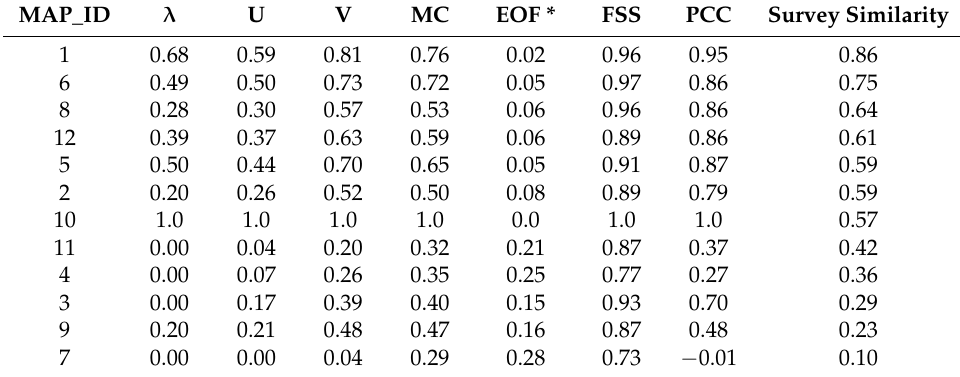
* Highest EOF value is zero for similar